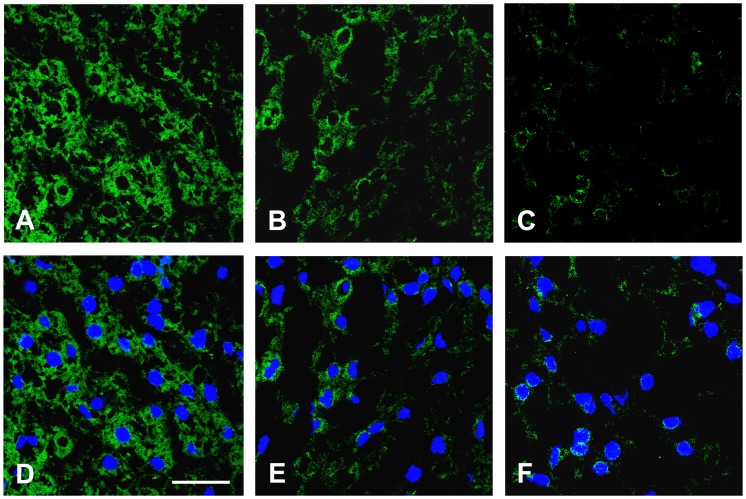
Representative confocal immunofluorescence for expression and intracellular distribution of Klotho co-receptor.The representative confocal immunofluorescence was performed on liver tissue cryostat sections OCT-embedded. The staining of Klotho co-receptor in the overweight-obese children without NAFLD (A), in the NAFLD overweight-obese children without NASH (B), and in the overweight-obese children with NASH (C) is shown in green. The nuclei are revealed by specific DAPI staining, displayed in blue. The white bar represents a 30 µm length.